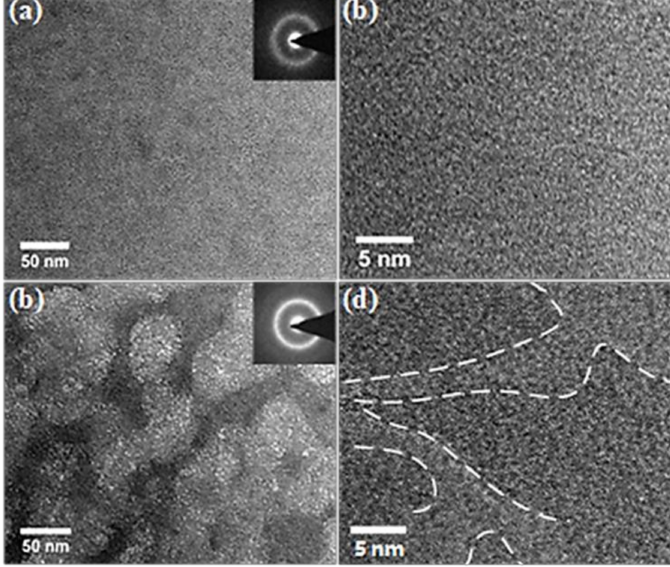
Figure 3. HRTEM structure before ( a , b ) and after ( c , d ) fully confined compression deformation. Figure 4 shows the SAXS scattering intensity for both as-cast and compressed specimens at the low Q position. Q value variation is related to the scattering angle: Q = 4 π Sin θ / λ . Here, θ is half of the scattering angle between the incident and scattered beam. λ is the X-ray wavelength. It is clear from the figure that the scattering intensity increases obviously after compression deformation, which indicates enhanced structural inhomogeneity at nanoscale after